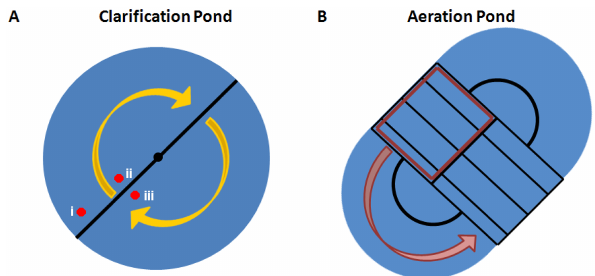
Figure 2. Schematic of the two basins that were measured with the floating chamber. (a) Clarification basin: the yellow arrow shows the direction in which the arm rotates. The red dots and symbols refer to the location of the chamber during runs 1, 2, 3 (symbol i), 4, 5, 7 (symbol ii) and 6, 8, 9 (symbol iii). (b) Aeration basin: the red rectangle denotes the aeration area, the arrow the water flow.